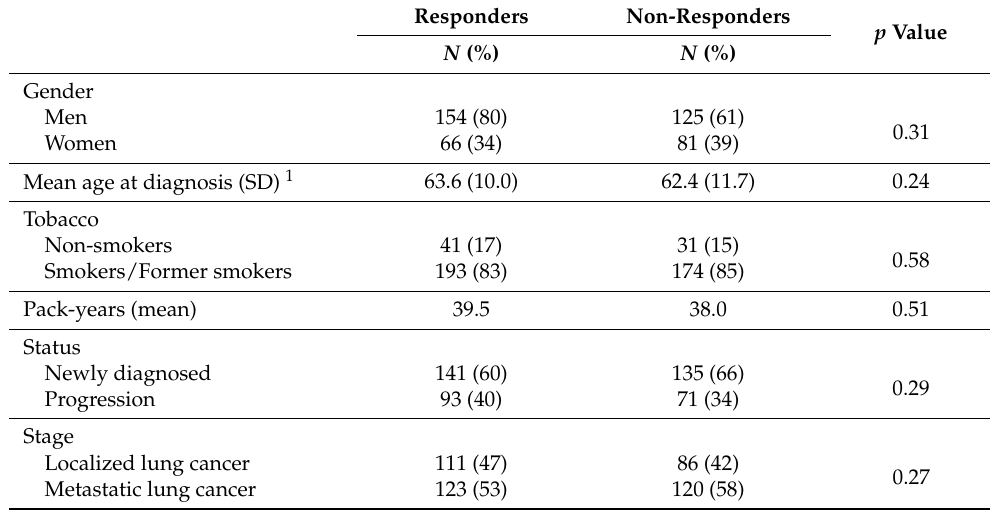
Summary of the characteristics for self-administered questionnaire responders and non-responders.